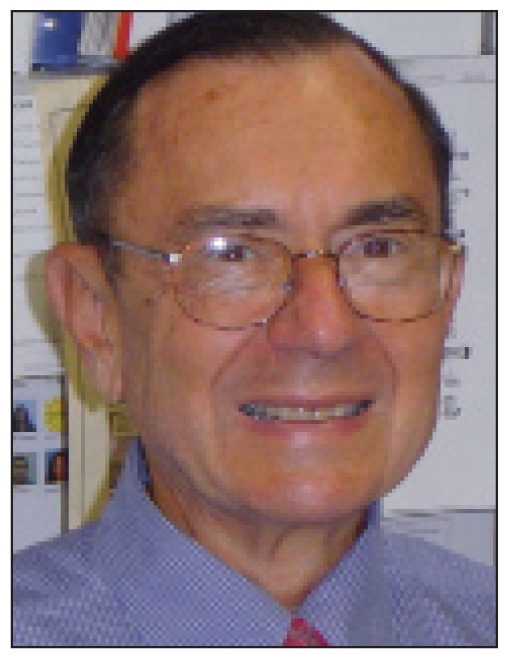
Arnold Schecter